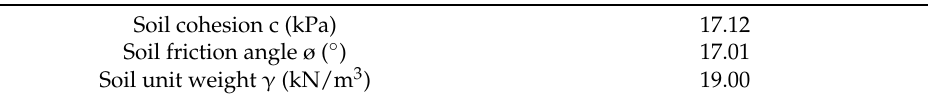
Table 1. Input soil parameters used in the application.